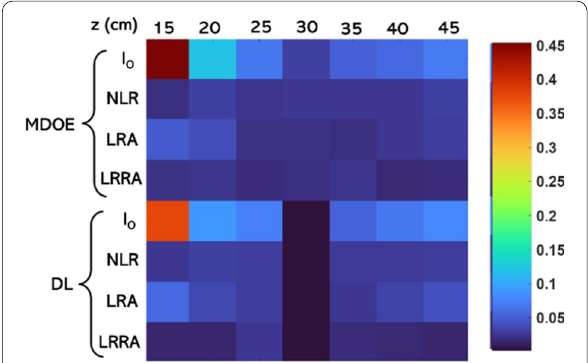
Fig. 6 MSE map for the different cases of Fig. 5 with respect to the reference image of the test object obtained by direct imaging using DL